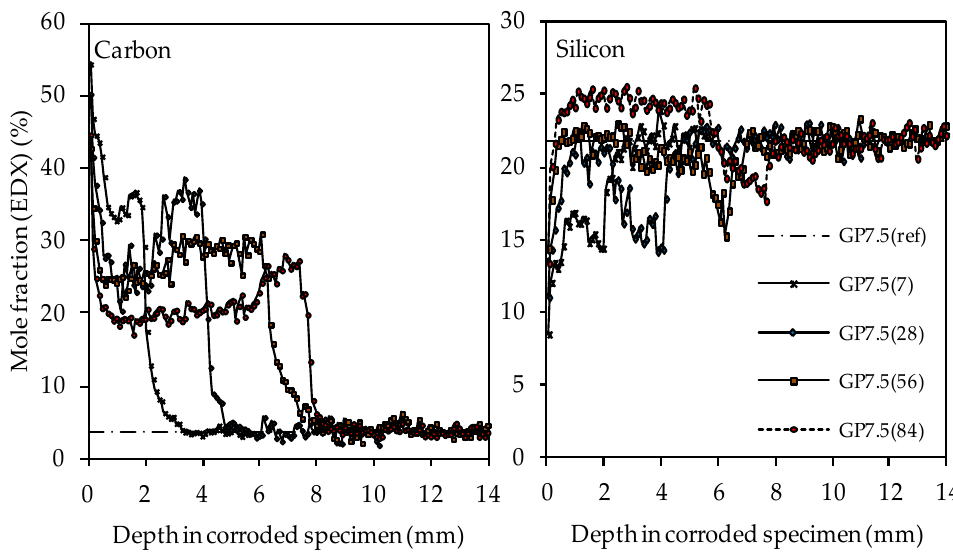
Figure 15. SEM-EDX mole fractions of carbon and silicon of geopolymer GP7.5. Mole fractions before (ref) and after (7, 28, 56, 84) exposure to sulfuric acid.